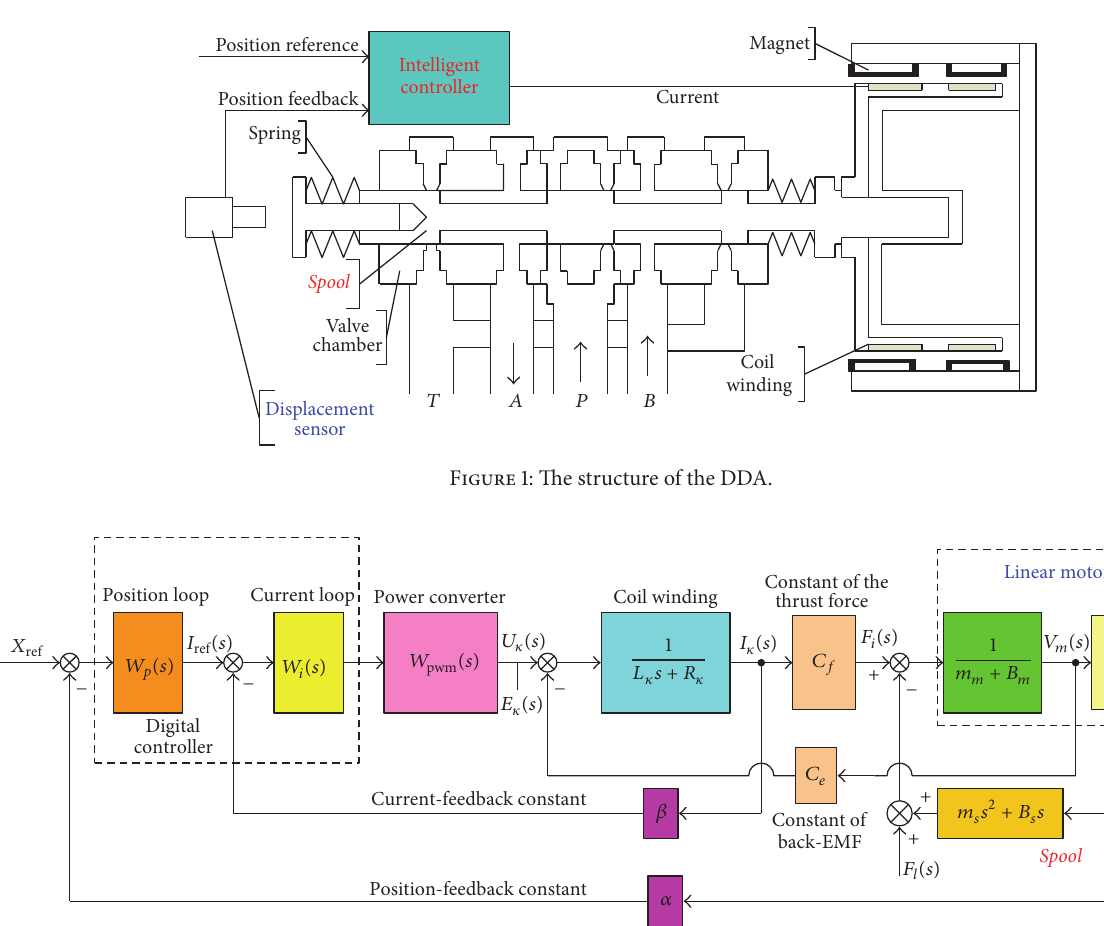
Figure 2: Block diagram of a double-loop intelligent